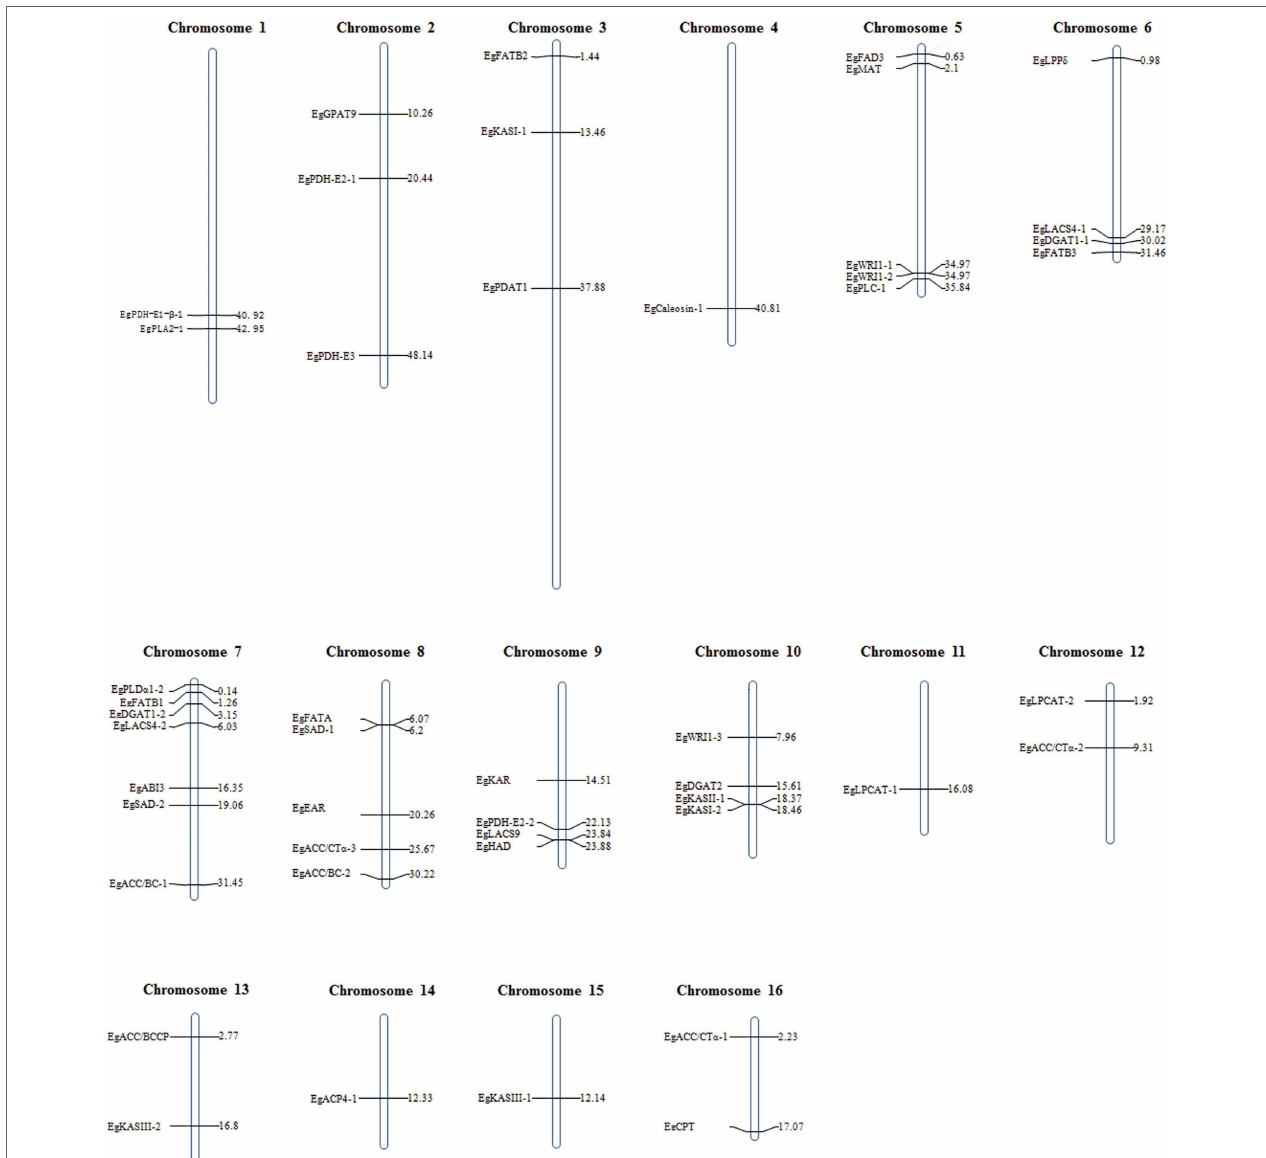
FIGURE 1 | Chromosomal positon of candidate genes involved in the biosynthesis of fatty acid identified in the genome of E.